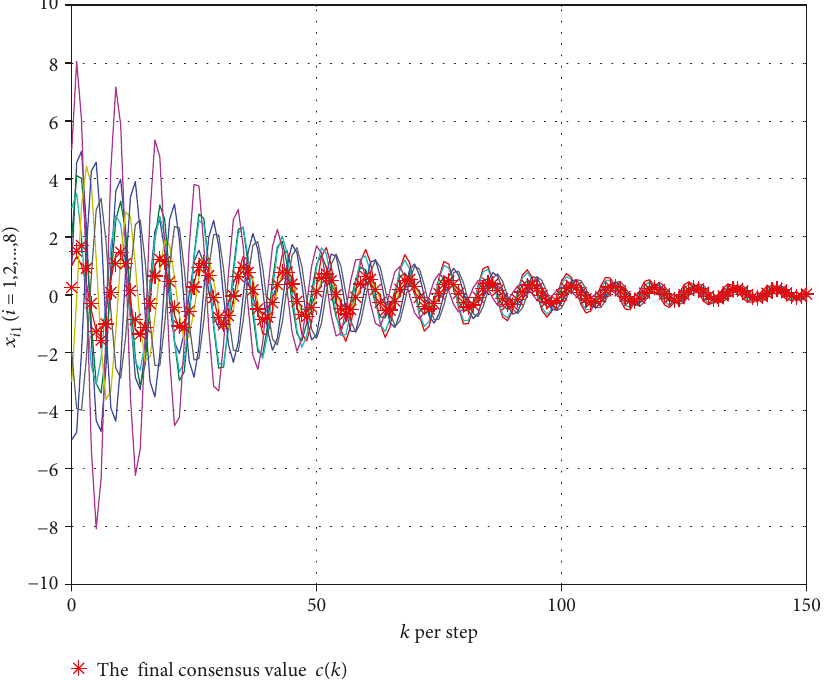
Figure 2: State 1 trajectories of swarm system (2).